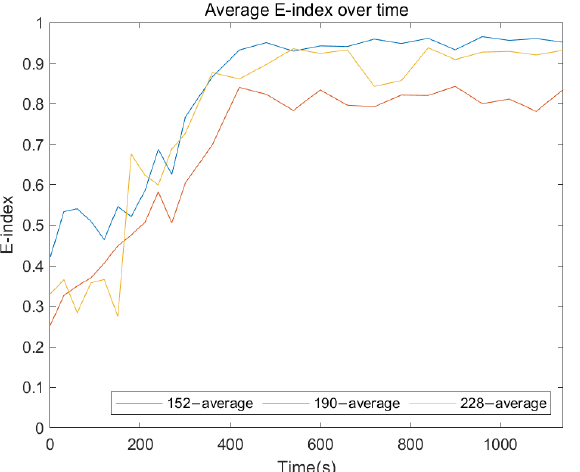
Figure 17. Average E ‐ index development as the function of cure time for three residual lengths.